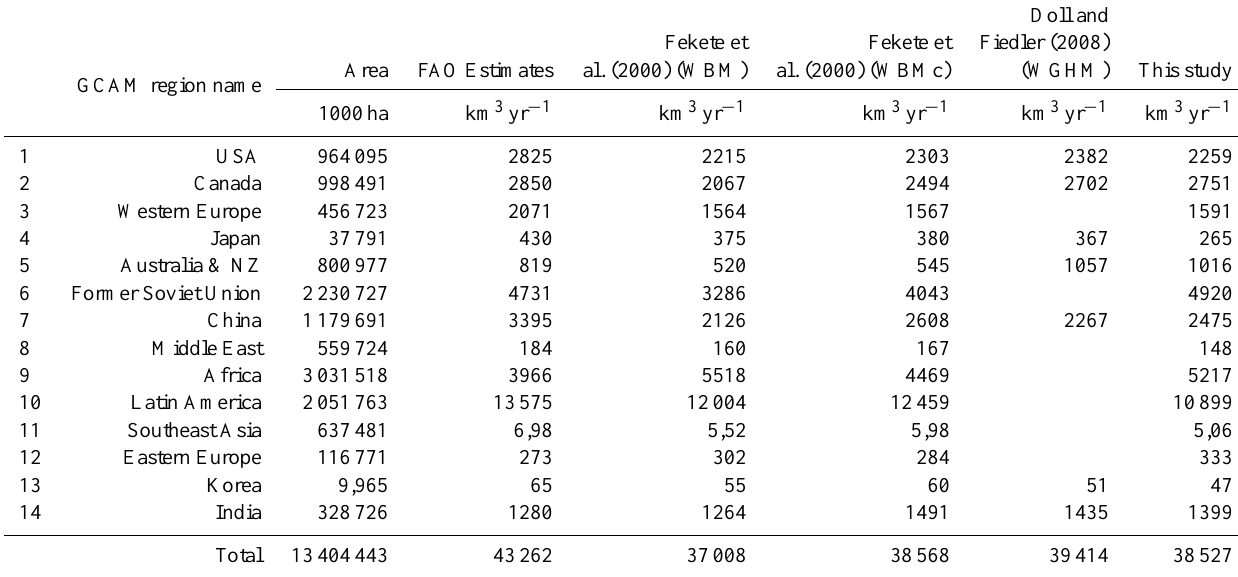
Table 2. Comparison of total mean annual runoff in each of the 14 GCAM regions with FAO estimates and two other global hydrologic models (WBM and